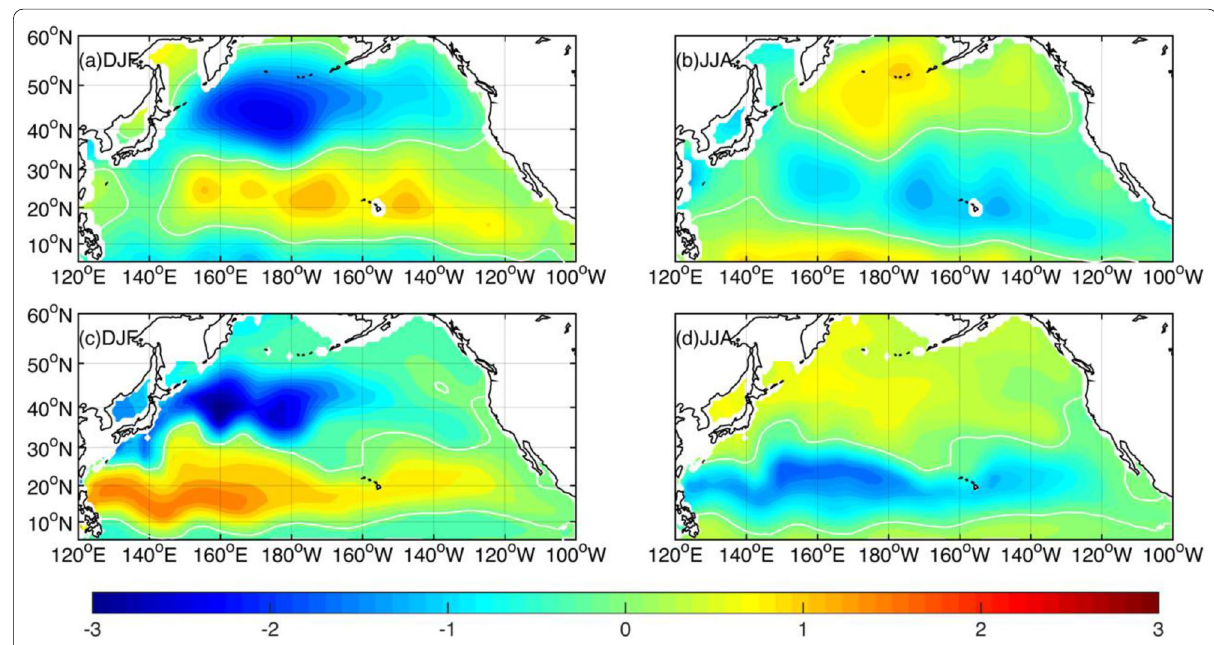
Fig. 3 Observed ( a , b ) and diagnostic ( c , d ) ocean bottom pressure anomalies (cm) in the northern Pacific during boreal winter and